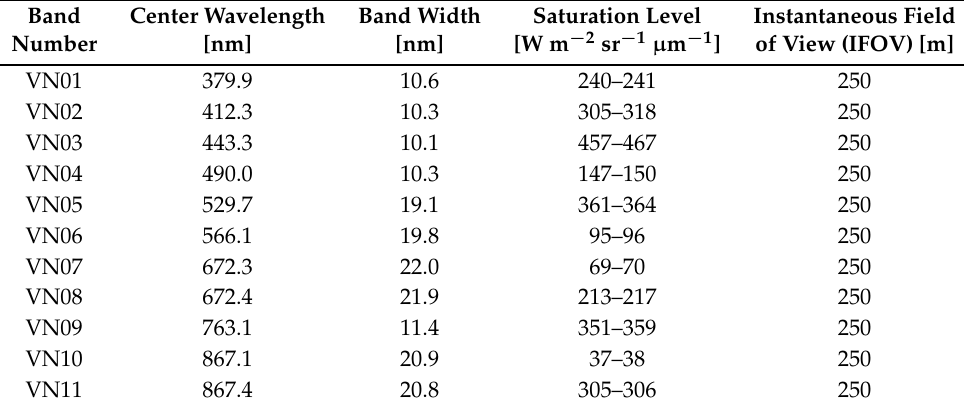
Figure 5. The relative spectral response (RSR) in the visible and near-infrared (NIR) range of Global Change Observation Mission-Climate (GCOM-C)/Second Generation Global Imager (SGLI). The original data was obtained from [58]. The solid black lines represent the wavelength at 531nm, 570nm, and 645nm, originally used to derive the photochemical reflectance index (PRI) and the chlorophyll carotenoid index (CCI). The blue, green, and orange dotted lines are reflectance measured by MS-700 at FHK on 9 April 2020 (DOY = 100), 18 July 2020 (DOY = 200), and 26 October 2020 (DOY = 300), respectively. Each reflectance was observed at 10:31:00 (Japan standard time (JST)) on each day. Table 4. Specifications of Visible and Near-Infrared Radiometer (VNR) of Second Generation Global Imager (SGLI) onboard Global Change Observation Mission-Climate (GCOM-C). The following information is based on GCOM-C data users handbook officially published by Japan Aerospace Exploration Agency (JAXA)